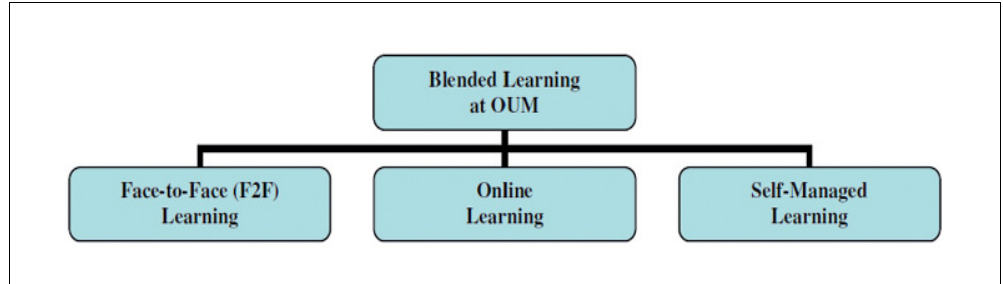
Figure 2 Means to manifest the teaching and learning process at Open University Malaysia (OUM): Blended